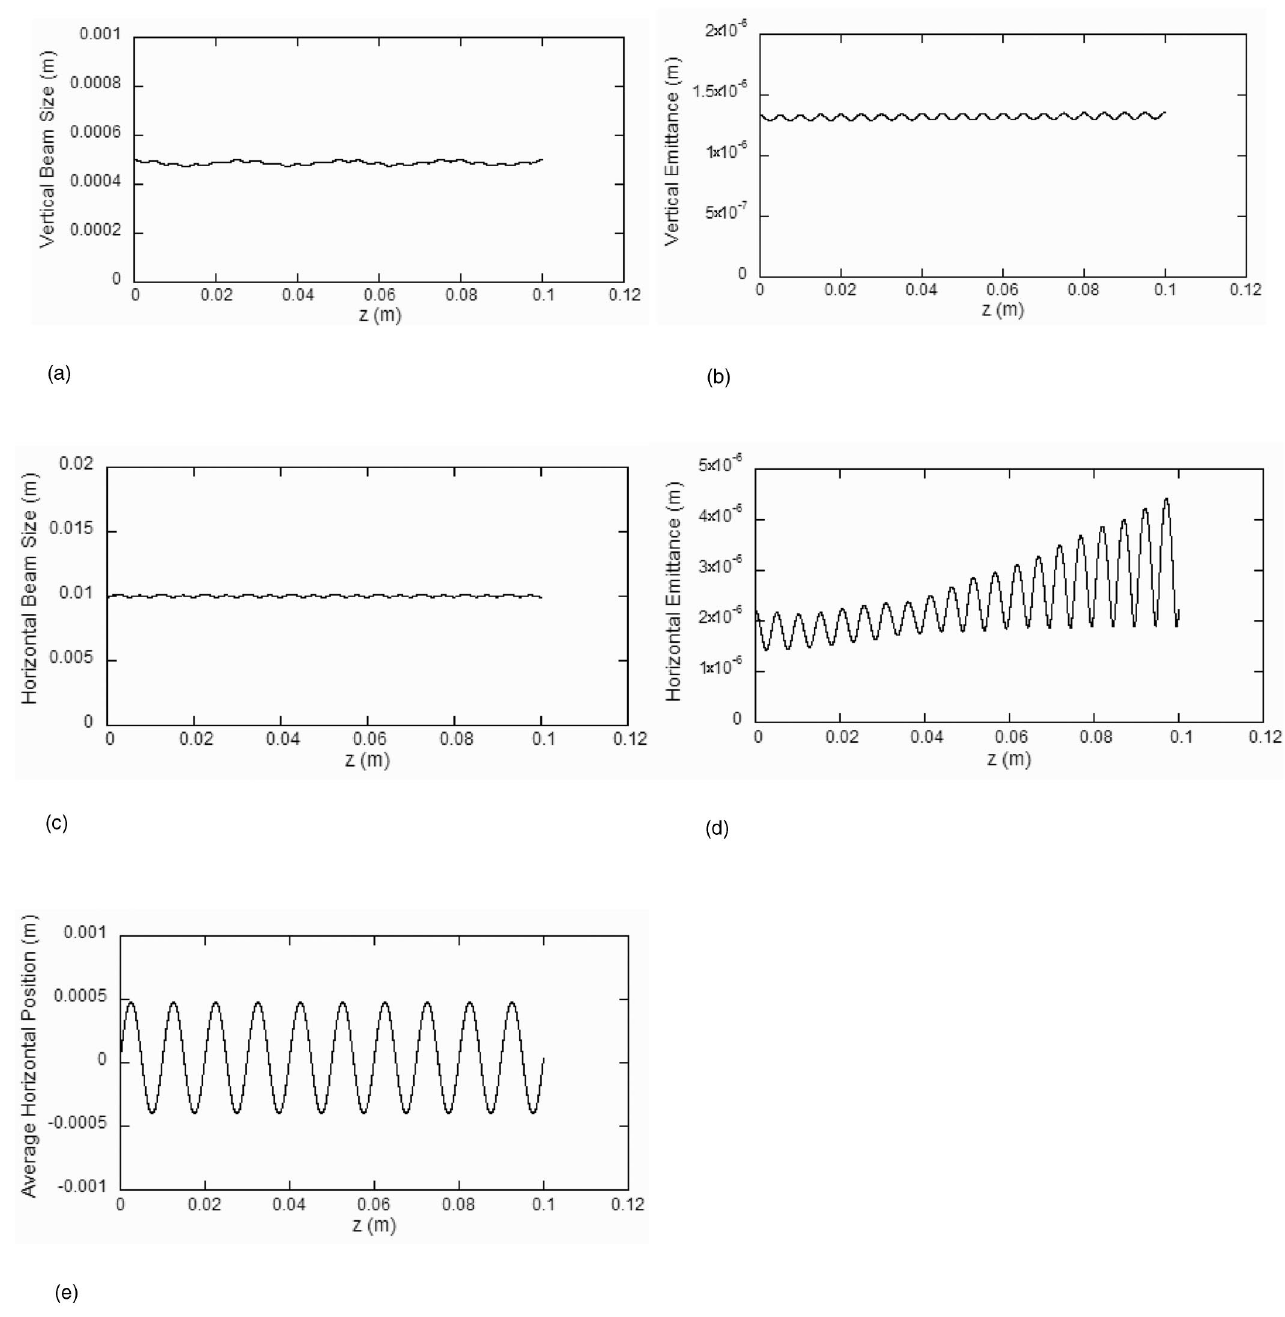
FIG. 2. Nominal PUSHER simulation of wiggler transport for the case with no space-charge, and transverse normalized emittances of 1.4 mm. (a) Vertical beam size versus axial distance. (b) Normalized vertical emittance fluctuation during the transport. (c) Horizontal beam size versus axial distance. (d) Normalized horizontal emittance fluctuation during the transport. (e) Average horizontal position of the beam, showing the clear horizontal ‘‘wiggling’’ of the